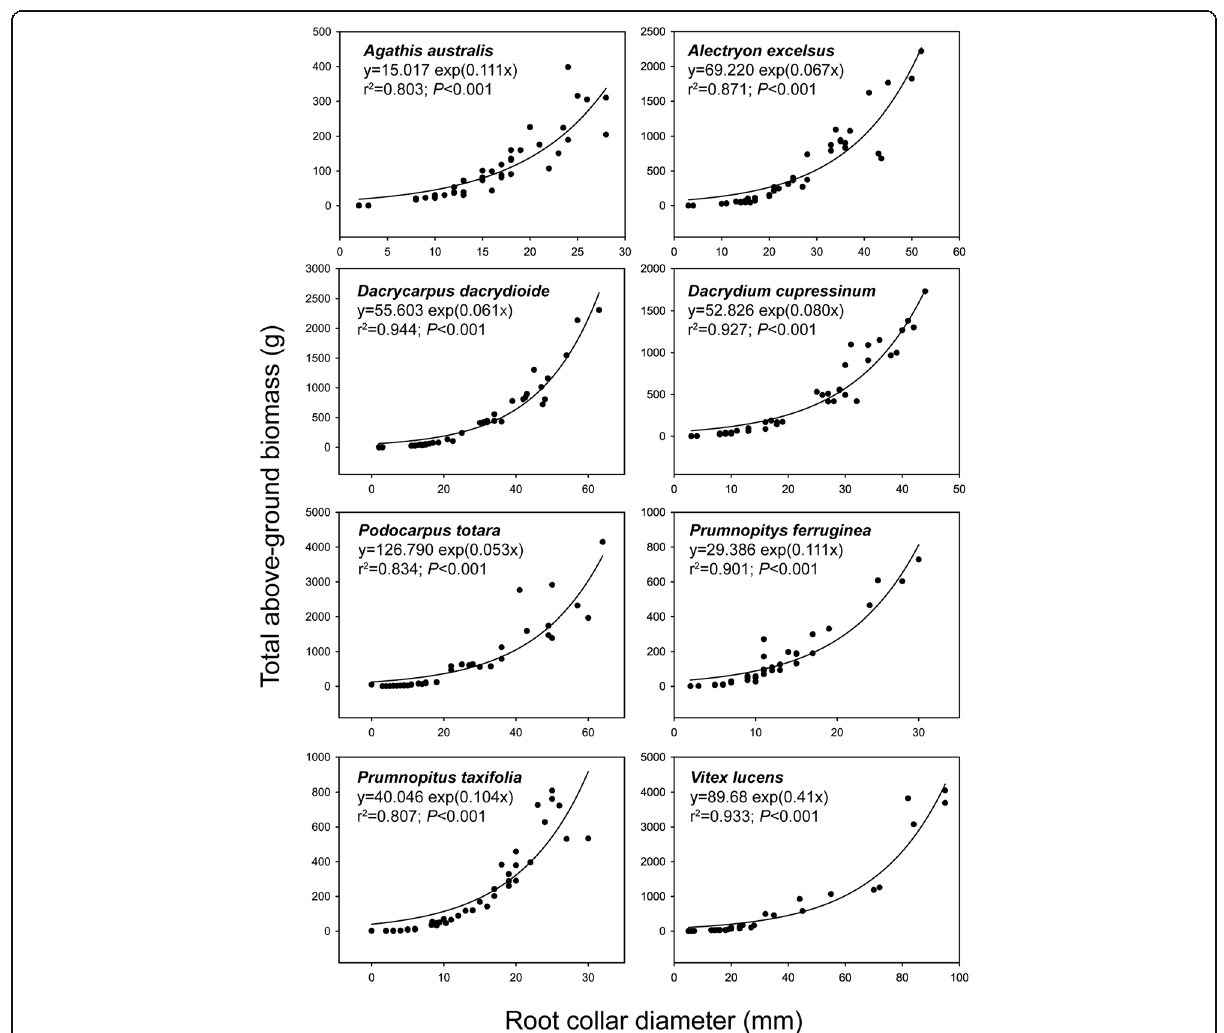
Fig. 4 Exponential growth analysis of RCD and total above-ground biomass. Note that the scale on the y and x axes differs between